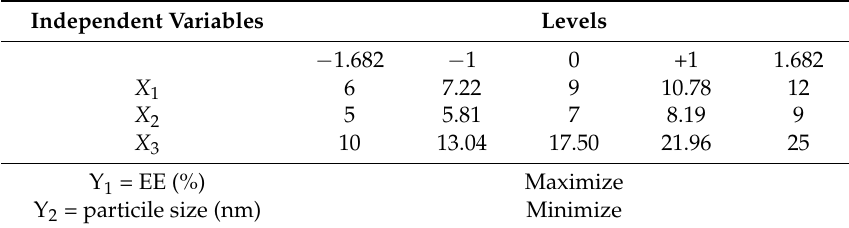
Table 6. Factors and responses in response surface-central composite